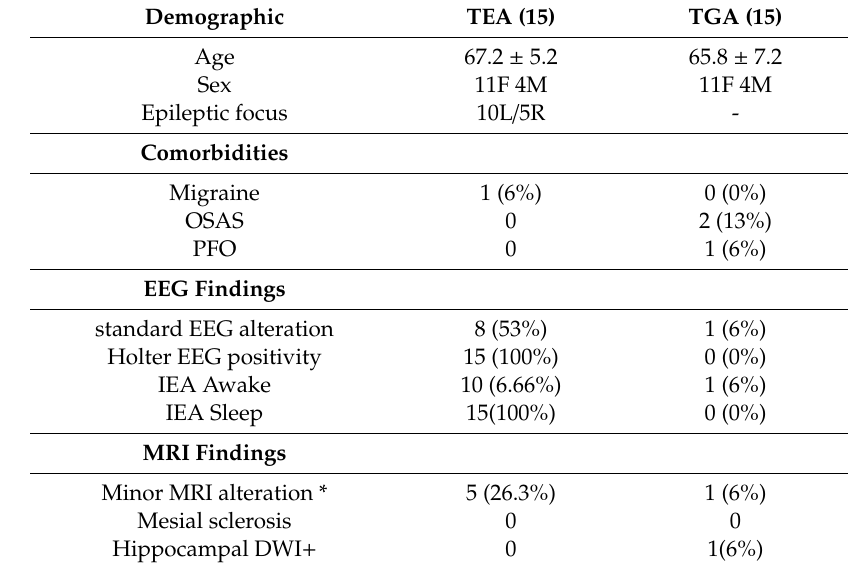
Table 1. Clinical and neurophysiological data from the TEA and TGA groups. * MRI noted as “minor alteration” were four cases of nonspecific gliosis and one small, sub-centimetric cavernoma in the TEA group, and one case of gliosis in the TGA group. Demographic TEA